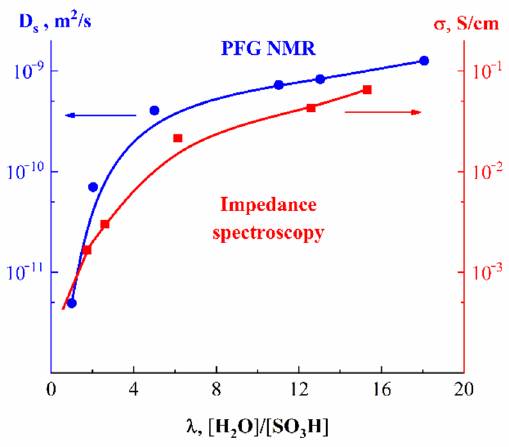
Figure 19. Dependences of the water self-diffusion coefficient and proton conductivity on humidity ( λ ), where λ is the amount of water molecules per sulfonate group in the acid form of the MF-4SC membrane. Reprinted with permission from Ref. [24]. Copyright 2021 MDPI.